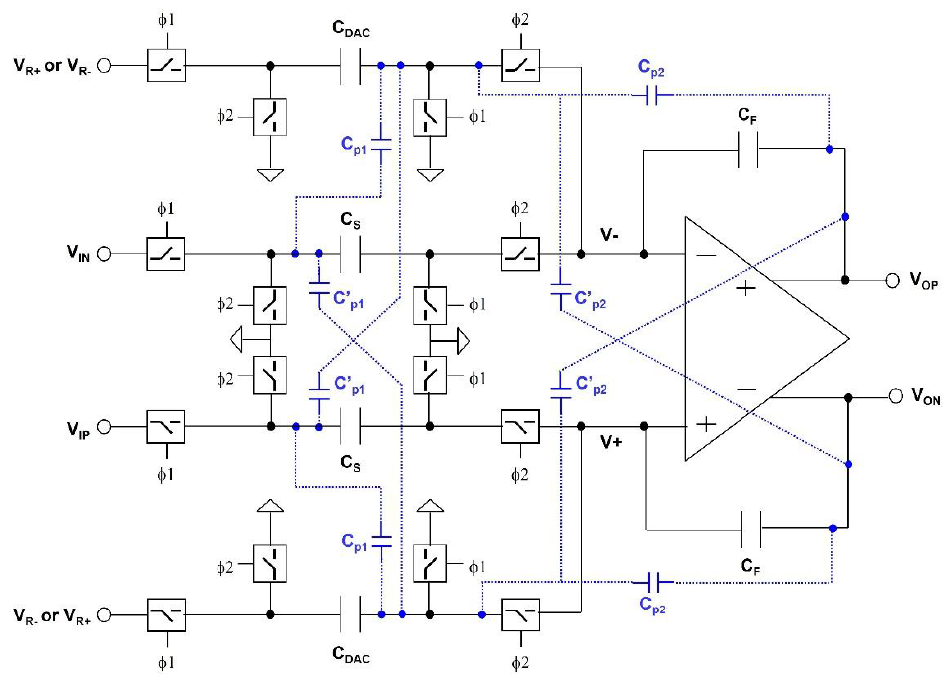
Figure 7. SC integrator macro model.